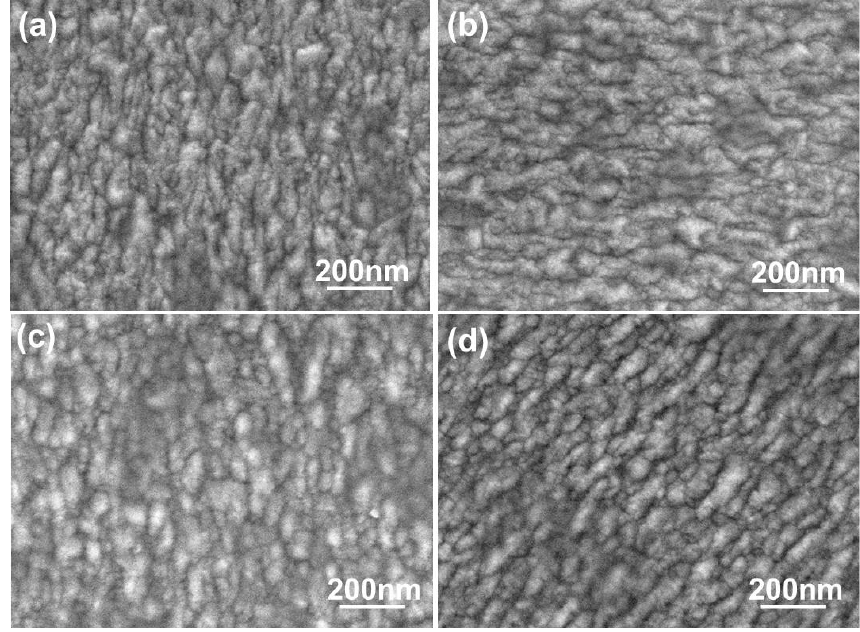
Figure 4. Surface SEM images of FZO films on PI substrates as a function of O 2 plasma pretreatment time: ( a ) 0 s, ( b ) 30 s, ( c ) 60 s, and ( d ) 420 s.